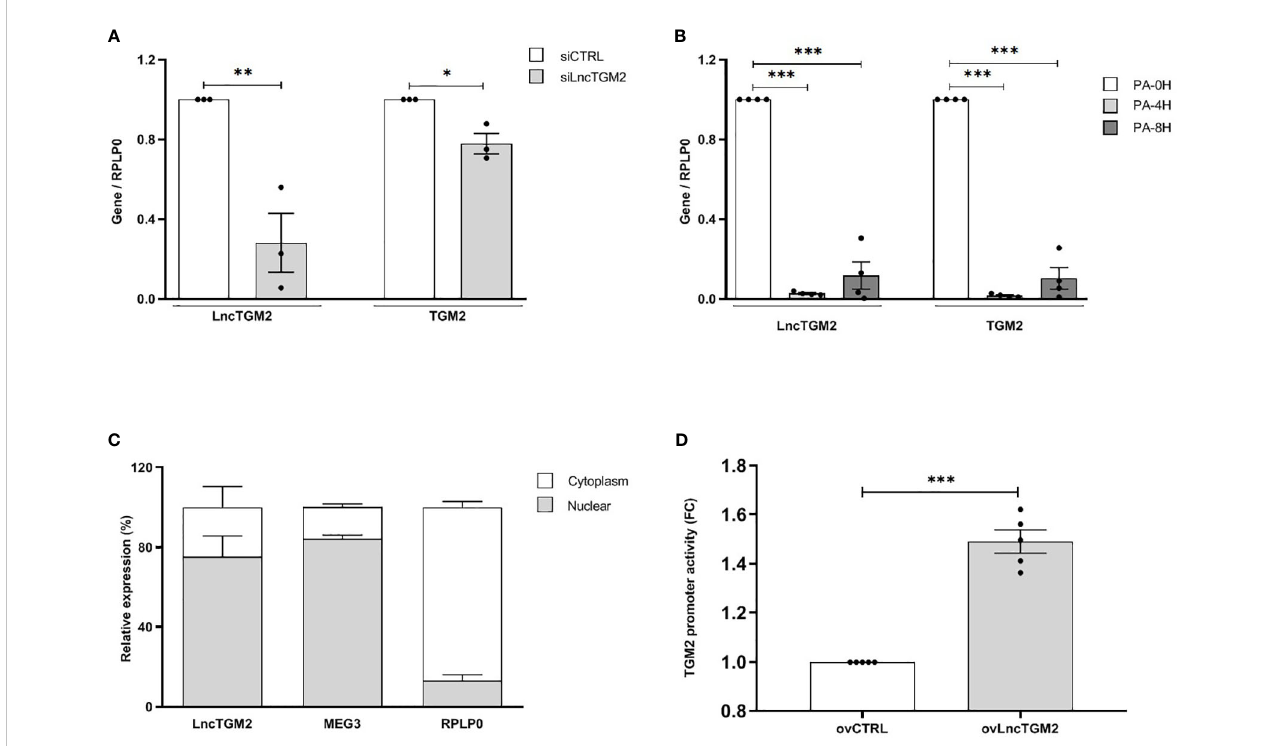
FIGURE 2 LncTGM2 co-expresses with TGM2 and regulates its transcriptional activity in pancreatic beta cells. (A) LncTGM2 was silenced in the EndoC- b H1 cell line using a siRNA, and (B) EndoC- b H1 cells were exposed to palmitate (0.5 mM) for 4 or 8h. LncTGM2 and TGM2 expression was assessed by RT-qPCR and normalized by the reference gene RPLP0 . The results are means ± S.E.M. of 3-4 independent experiments; *p < 0.05, **p < 0.01, and ***p < 0.001 by Student ’ s t-test. (C) RT-qPCR analysis of LncTGM2 , MEG3 (as nuclear marker) and RPLP0 (as cytoplasmic marker) in nuclear and cytoplasmic fractions in EndoC- b H1 cells. (D) HEK-293 cells were transfected with a control vector (ovCTRL) or a vector overexpressing LncTGM2 (ov LncTGM2 ), and co- transfected with a TGM2 promoter luciferase reporter construct plus a pRL-CMV plasmid (used as internal control). After 48h of recovery, bioluminescence was